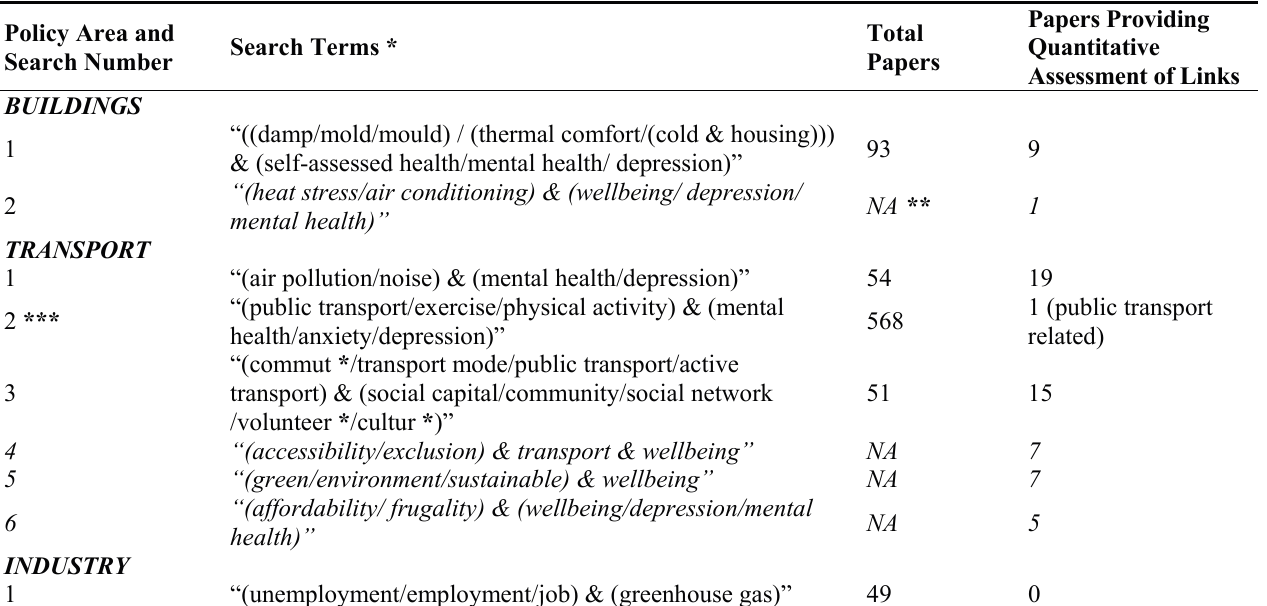
Table 1. Searches terms and